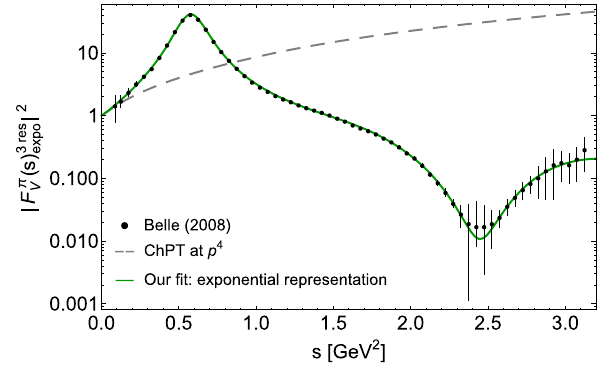
Fig. 1 Belle measurement of the modulus squared of the pion vector form factor (black solid circles) [31] as compared to our fit results (solid green line) as presented in Eq.(19). The ChPT calculation at O ( p 4 ) is also shown for illustration (dashed gray